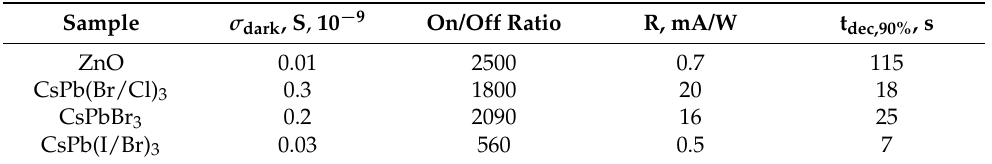
Table 3. Photoelectric parameters of ZnO/PNCs nanocomposites and non-sensitized nanocrystalline ZnO under blue LED irradiation ( λ max = 470 nm, 13 mW/cm 2 , 30 s) at room